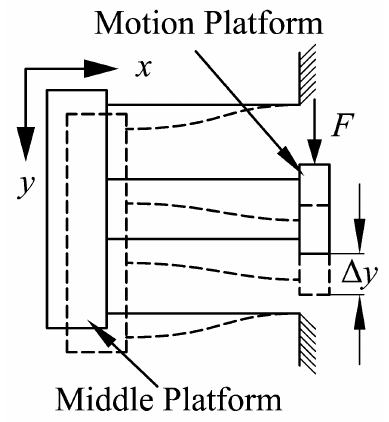
Figure 7. Deformation of the double parallelogram mechanism.